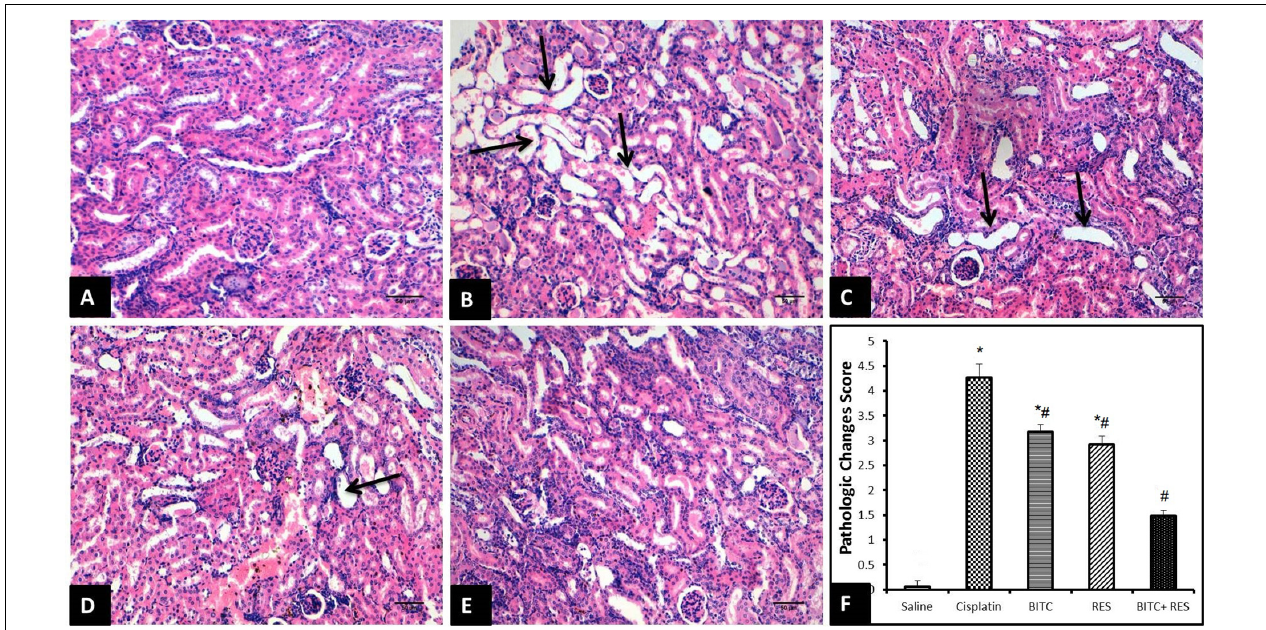
FIGURE 5 | H&E sections of the kidney (Bar = 50 µ m). (A) Saline-treated mice revealing normal kidney tissue morphology. (B) Cisplatin-treated mice revealing marked dilation and twisting of several renal tubules (arrows). (C) Slight improvement of renal tissue in CDDP–RES-treated mice (arrows). (D) Moderate histopathologic changes are seen in CDDP–BITC-treated mice (arrow). (E) Mice treated with BITC and RES combination showing mild morphologic changes. (F) Semiquantitative analysis of the histopathological changes ( ∗ significantly different from the normal control group at p < 0.05, # significantly different from the CDDP group at p < 0.05).